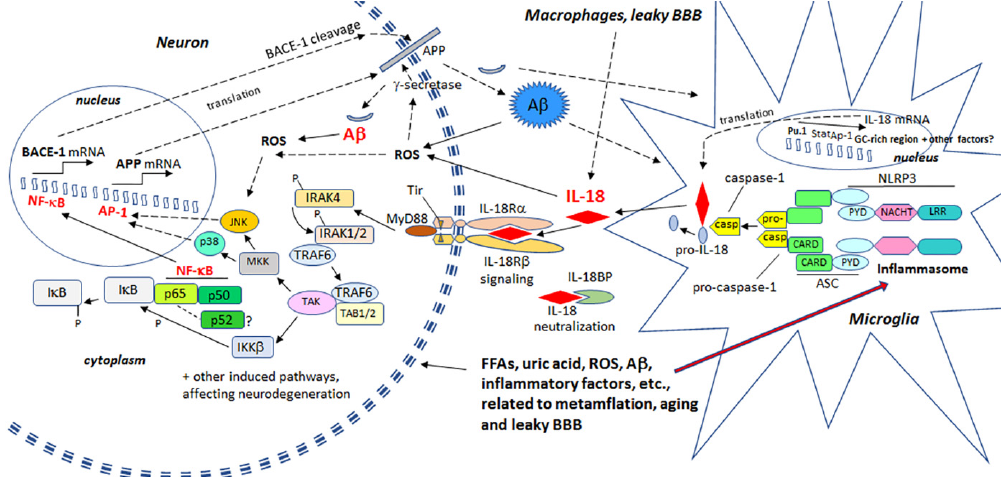
Figure 6. IL ‐ 18 enhances BACE ‐ 1 and APP production leading to increase in A β levels. Microglia and Figure 6. IL-18 enhances BACE-1 and APP production leading to increase in A β levels. Microglia and reactive astrocytes are the main producers of IL ‐ 18 in the brain. Expression of IL ‐ 18 is regulated by reactive astrocytes are the main producers of IL-18 in the brain. Expression of IL-18 is regulated by transcription factor PU.1, and the other regulatory areas include GC ‐ rich region, AP ‐ 1 and STAT transcription factor PU.1, and the other regulatory areas include GC-rich region, AP-1 and STAT binding sites [160,161]. IL-18 can enhance transcription factors NF- κ B and AP-1 [162]. Angiotensin II, implicated in atherosclerosis, is one inducer of IL-18 expression [162], whereas numerous inflammasome activators lead to activation of caspase-1 and increase in secretion of bioactive IL-18. NF- κ B has a role in BACE-1 in regulation [25,26], whereas expression of APP is modulated by AP-1 [163]. Both NF- κ B and AP-1 are also inducible by ROS. AP-1, activator protein 1 transcription factor; IKK, inhibitor of κ B kinase; IRAK, Interleukin-1 receptor-associated kinase; IL-18BP, IL-18 binding protein; JNK, c-Jun N-terminal kinase; LRR, leucine-rich repeat; MKK, mitogen-activated protein kinase kinase; MyD88, myeloid differentiation primary response gene 88; NACHT, NAIP (neuronal apoptosis inhibitor protein), C2TA (class 2 transcription activator of the major histocompatibility complex, HET-E (heterokaryon incompatibility), TP1 (telomerase-associated protein 1); NLRP, NLR (nucleotide-binding domain, leucine-rich repeat) family, pyrin domain containing; Pu.1, PU-box (a purine-rich DNA sequence (5 (cid:48) -GAGGAA-3 (cid:48) )) binding transcription factor (SPI1; Spi-1 proto-oncogene); PYD, pyrin domain; Stat, signal transducer and activator of transcription; TAB, TGF- β (transforming growth factor- β )-activated kinase and MAP3K7-binding protein; TAK, mitogen-activated protein kinase kinase kinase (MAP3K); Tir, Toll/interleukin-1 receptor homology domain; TRAF6, TNF (tumor necrosis factor) receptor associated